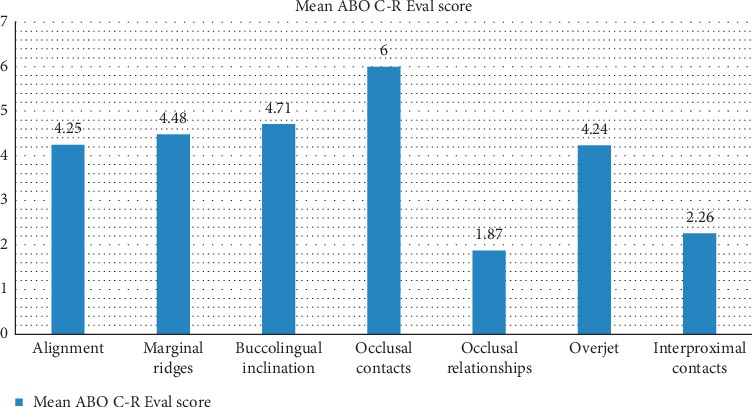
Average ABO OGS score per cast parameter.